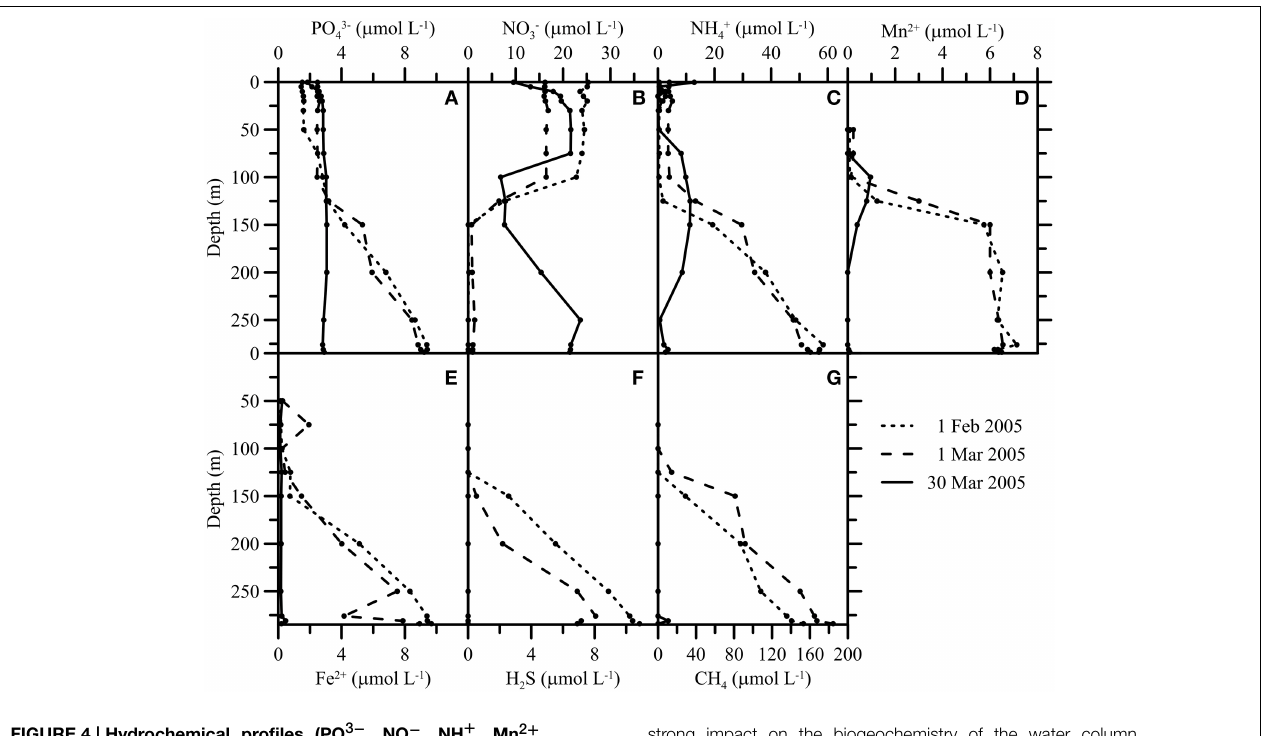
FIGURE 4 | Hydrochemical profiles (PO 3 − 4 , NO − 3 , NH + 4 , Mn 2 + , Fe 2 + , H 2 S, CH 4 ) (A–G) before (1 February and 1 March) and after (30 March) the mixing event in 2005. The mixing had a